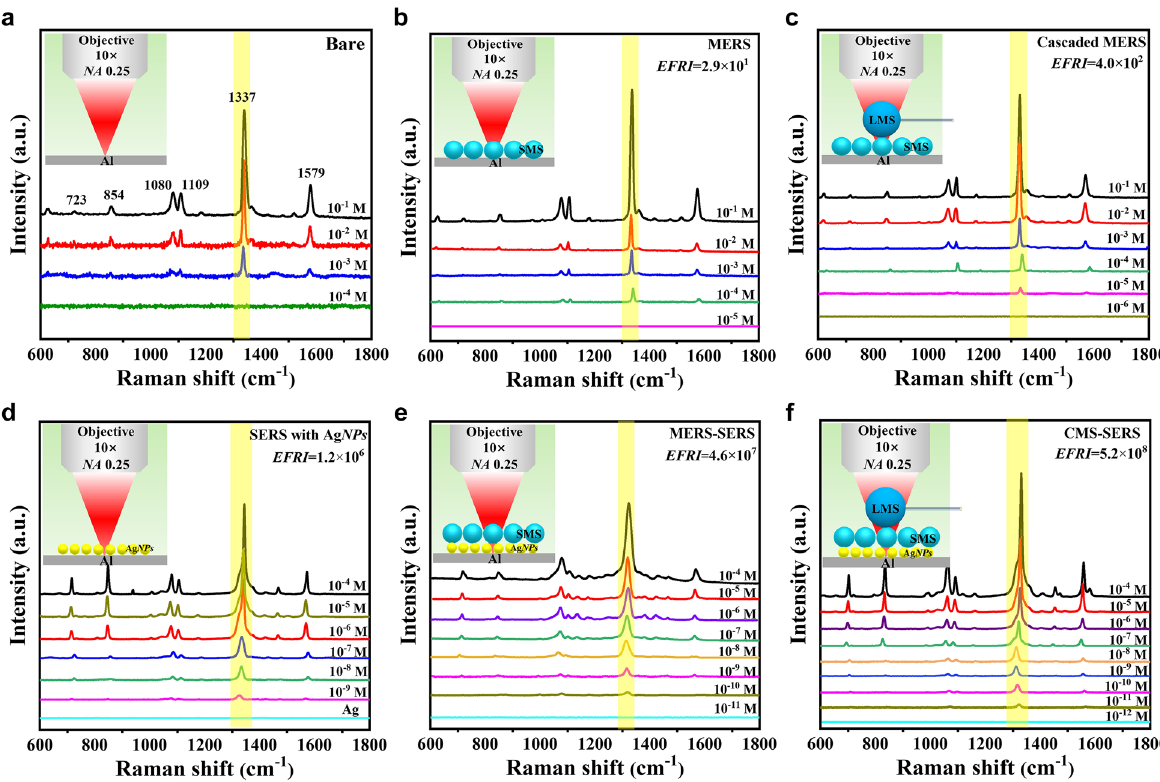
Figure 2: Evaluation of enhancement factor and sensitivity of Raman scattering by various configurations with (a) bare Al substrate, (b) MERS enhancer (with SMS), (c) cascaded MERS enhancer (with LMS/SMS), (d) SERS enhancer (with Ag NP s), (e) MERS-SERS enhancer with (SMS/ Ag NP s), and (f) CMS-SERS enhancer with a LMS/SMS/Ag NP s structure, for 4-NBT down to 10 − 11 M in aqueous